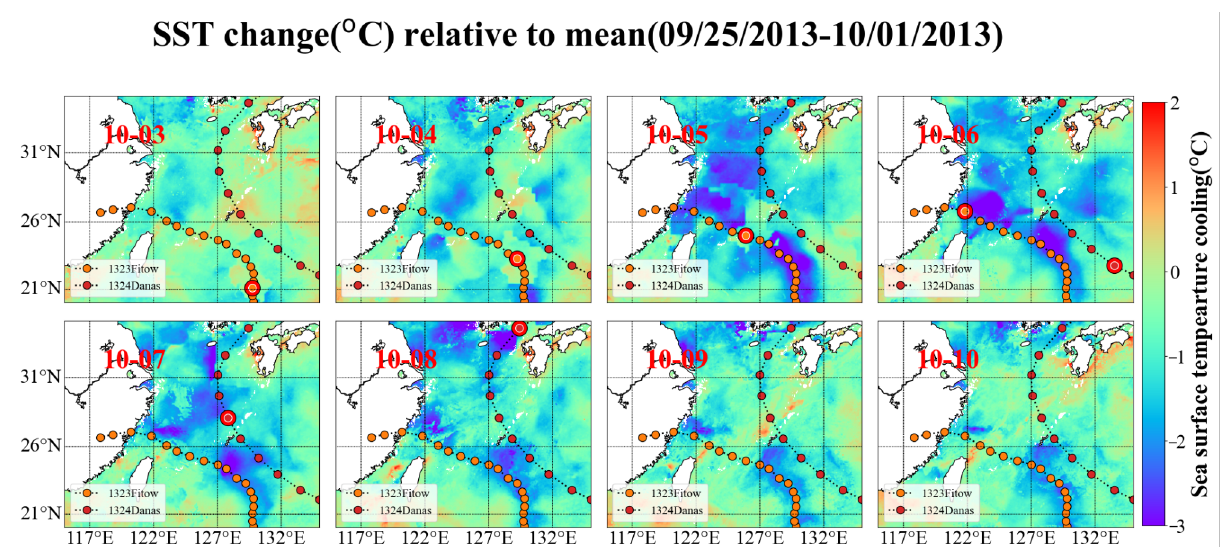
Figure 12. The change in daily sea surface temperatures from October 3 to 10 relative to the pre- typhoon state. The big circle in red is the location of the typhoon at 12:00 that